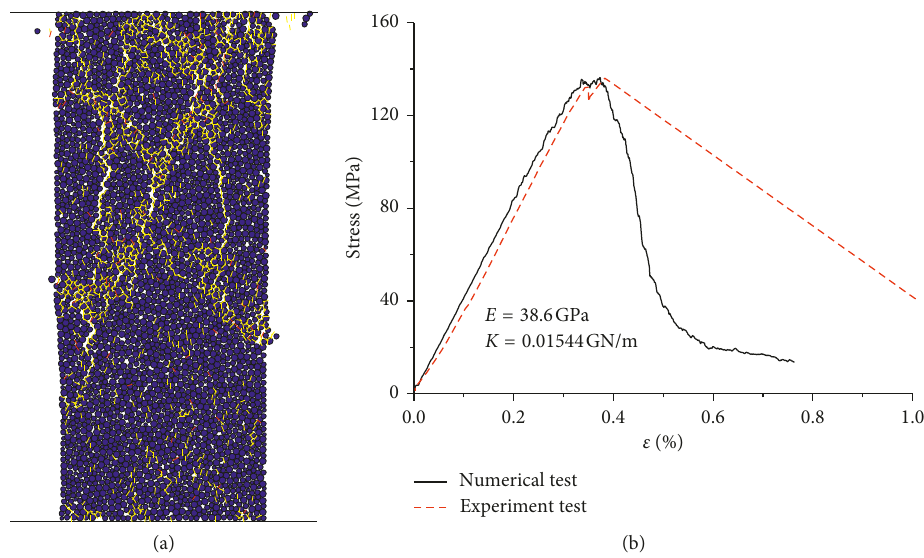
Figure 6: (a) Uniaxial compressive test on an intact specimen and (b) stress-strain curve for the intact rock and the calculated stiffness.